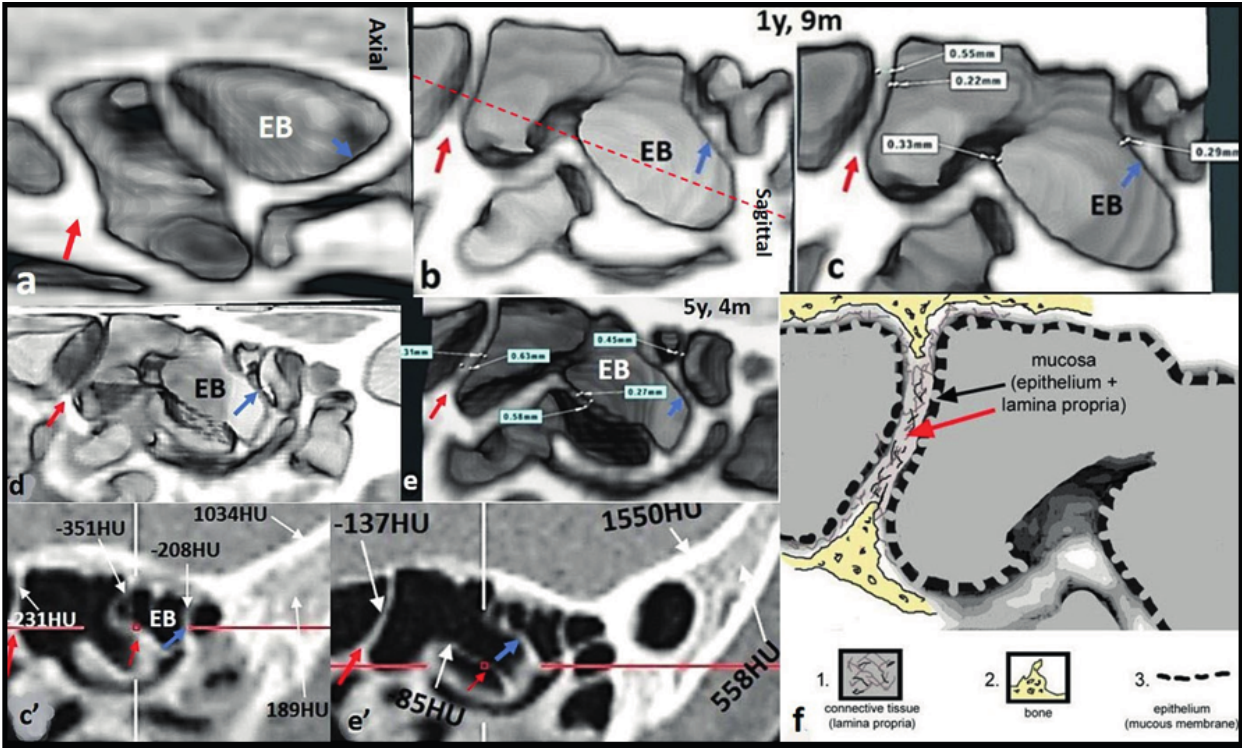
Figure 6. The “dark membranes” and the evolving ES cartilage/bone formation over a three-year, seven-month interval. a.-c. Left lateral nasal wall of a one year and nine-month-old patient focused on the anterior ES. Note in fig. (a.) a 3D axial image, with its angulation corresponding to the plane of the red dashed line in the sagittal 3D image fig. (b.) showing the anatomy between the BL (blue arrow) and the Basal Lamella (red arrow). Note in fig. (c.) the “dark membranous sheath” highlighted in the slightly magnified fig. (b.) covering the cartilaginous/bony out- lines, and “sandwiching” the cut lamellae. Note the “membrane’s” thickness is approximately 0.22 – 0.33mm. The thickness of the superior MT Basal Lamella is approximately